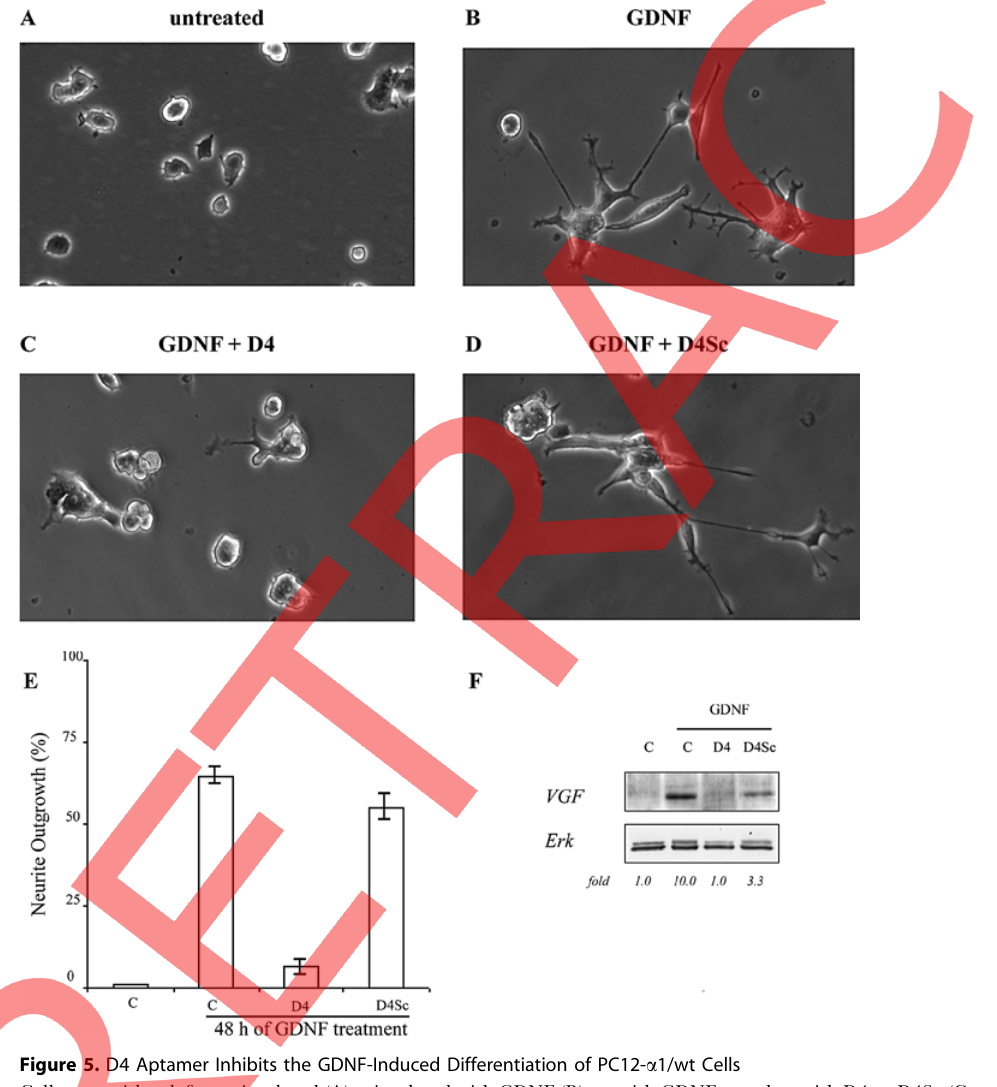
Figure 5. D4 Aptamer Inhibits the GDNF-Induced Differentiation of PC12- a 1/wt Cells Cells were either left unstimulated (A), stimulated with GDNF (B), or with GDNF together with D4 or D4Sc (C and D, respectively). Following 48 h of GDNF treatment, the percentage of neurite outgrowth was calculated. The data represent the average of three independent experiments and are expressed as percentage of neurite-bearing cells/total cells analyzed (E). Following 48 h of treatment, cells were lysed and proteins immunoblotted with anti-VGF antibodies. Equal loading was confirmed by immunoblotting with anti-ERK antibodies as indicated